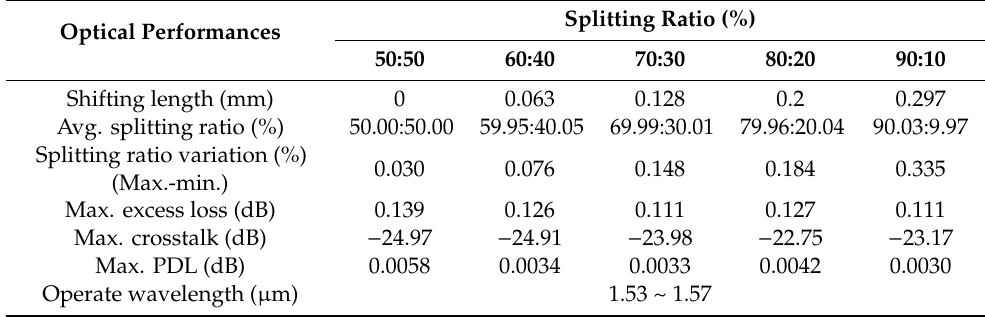
Table 1. Splitting ratios for various shifting length L s and optical performances characteristics.